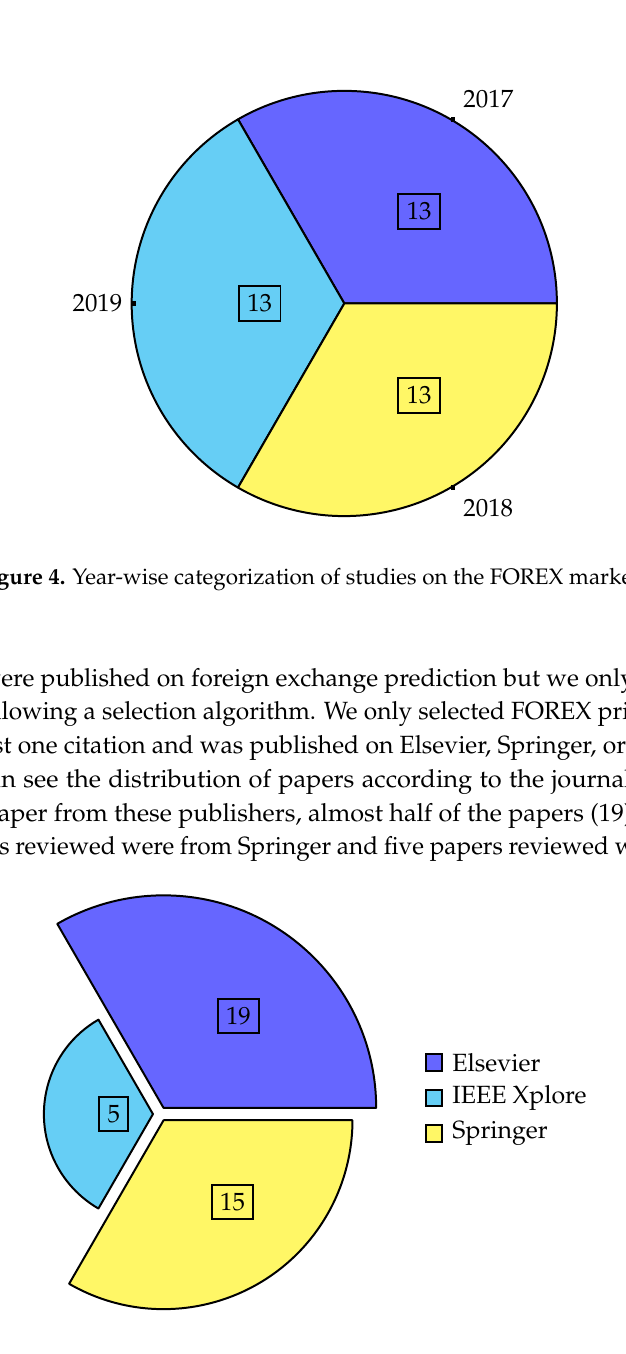
Figure 5. Distribution of papers according to the